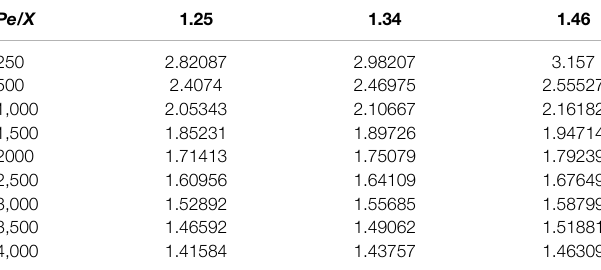
TABLE 6 | Average turbulent Prandtl number under different P/D and Pe . Pe / X